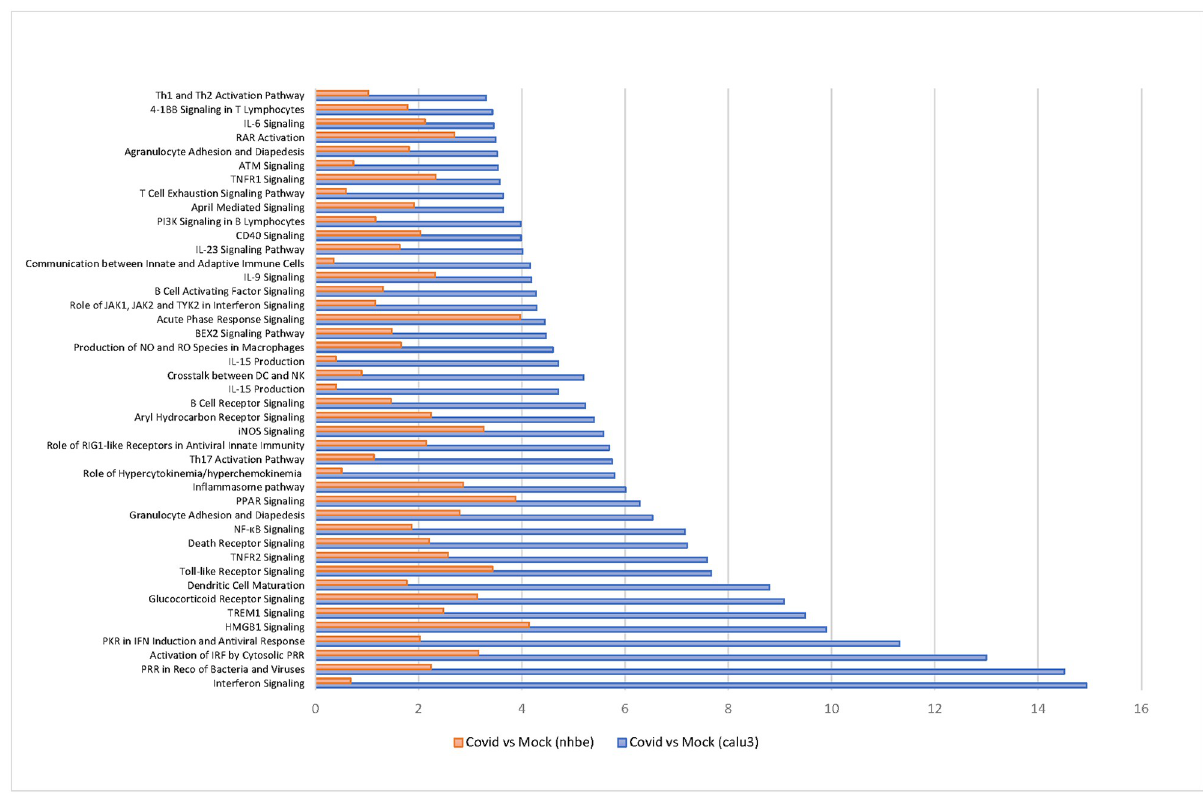
Fig 3. Pathway enrichment analysis from disease signatures (COVID-19 versus mock) in epithelial cell lines infected by SARS-CoV-2. The top 40 most significantly dysregulated immunological canonical pathways in either the Calu-3 (yellow) and NHBE (brown) infected cell lines are represented in a radar plot according to -log ( p -value). Pathway enrichment z -scores, based on fold change direction, represent predicted up-regulation (green dots) or down-regulation (blue dots) for positive or negative values, respectively.